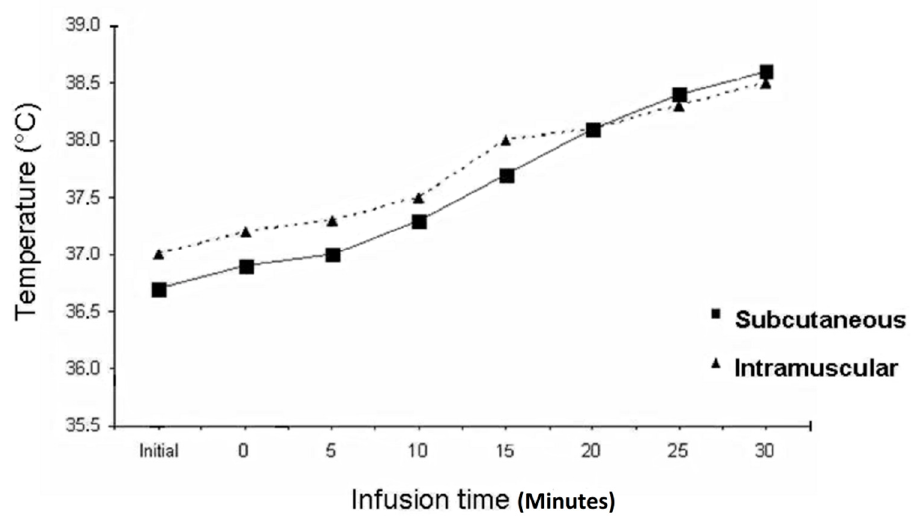
Figure 4. Typical temperature graph during isolated limb infusion. True hyperthermia (>41 ◦ C) causes further vascular damage and cell apoptosis, in- creasing chemo- and radiosensitivity of tumours; however, it also causes rapid degra- dation of melphalan resulting in reduced effective concentrations and higher toxicity rates